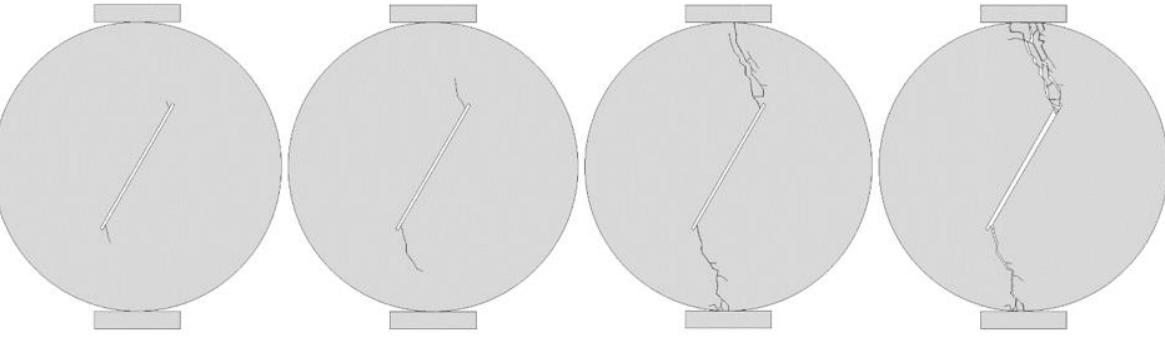
Figure 5. Fracture process for Brazilian disc with a crack of 30° angle.